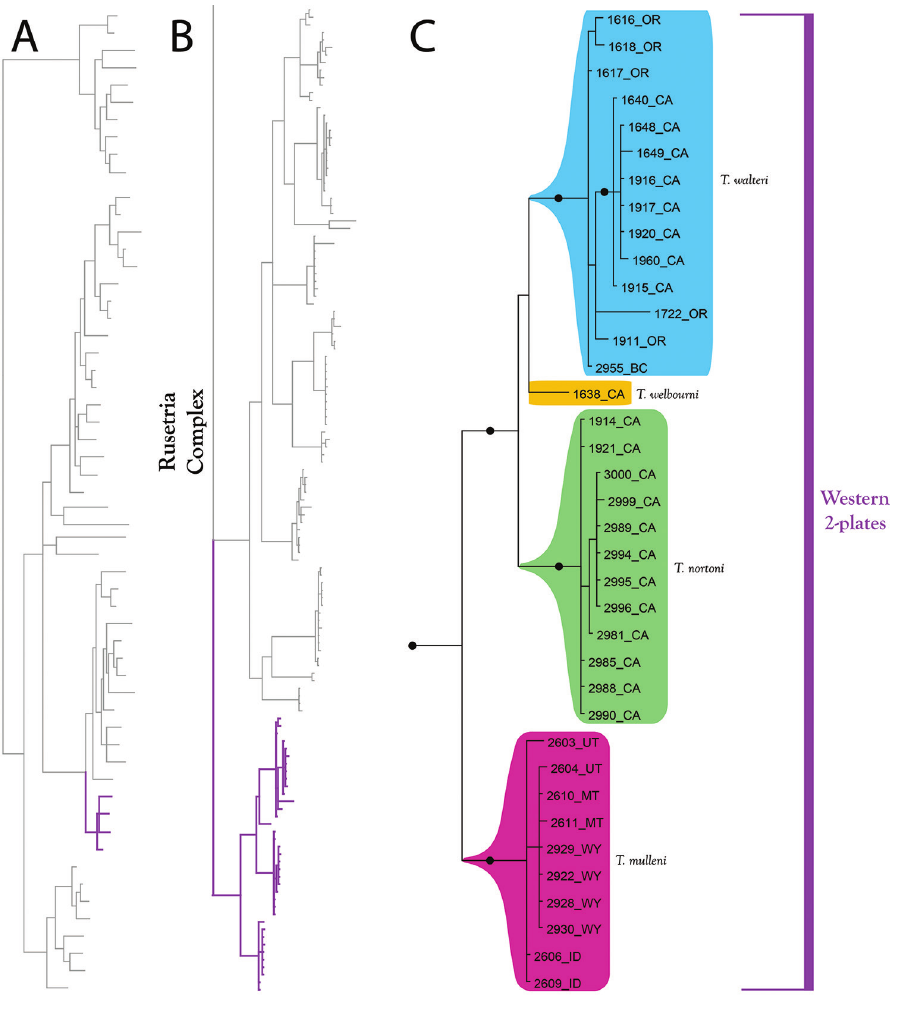
Figure 16. Rusetria Complex (part III). All species are western. A Species guide (overview of 28S+COI analysis from Figure 7–8) B Overview of Rusetria Complex from Figure 9 (COI-only analysis from Figure 9) C Detail of Rusetria Complex (in part) from B. D Detail of Rusetria Complex (in part) from Figure 9. Colored lineages in A and B correspond to Group names and brackets in C. Dots denote posterior probably of greater than 95%. Taxa are displayed by DNA number and state (U.S.) or territory (Canada)